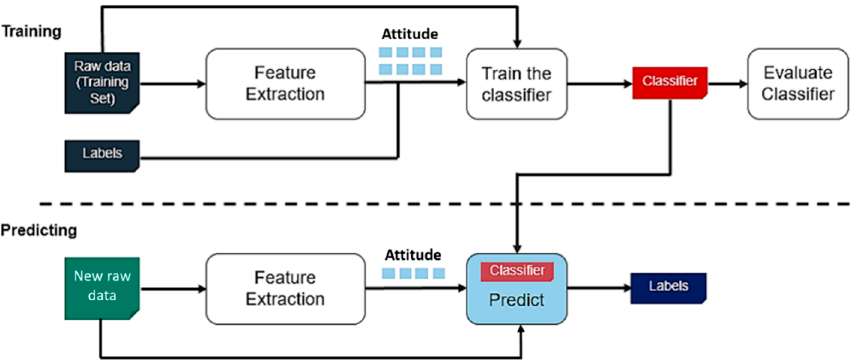
Figure 6. Proposed approaches for HAR with raw data or attitude.